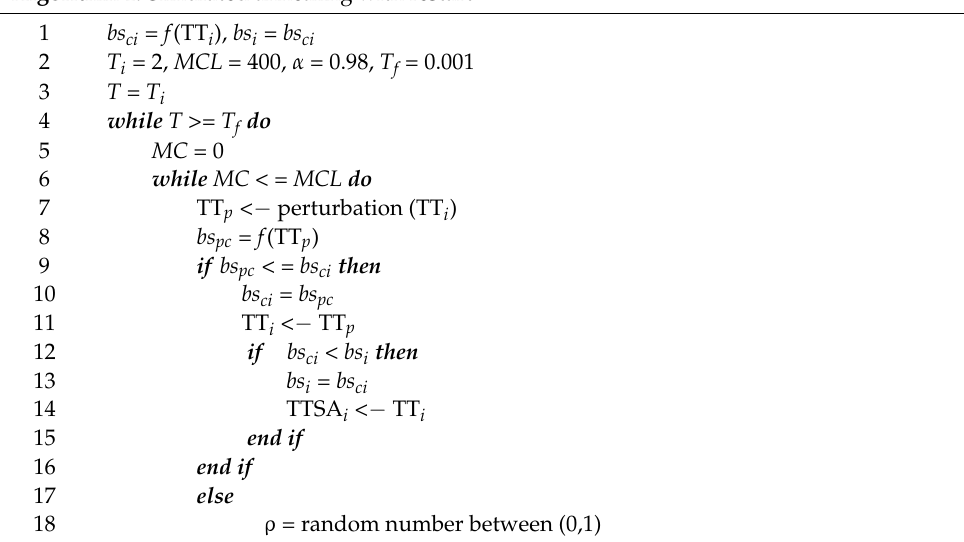
Algorithm 1. Simulated annealing with